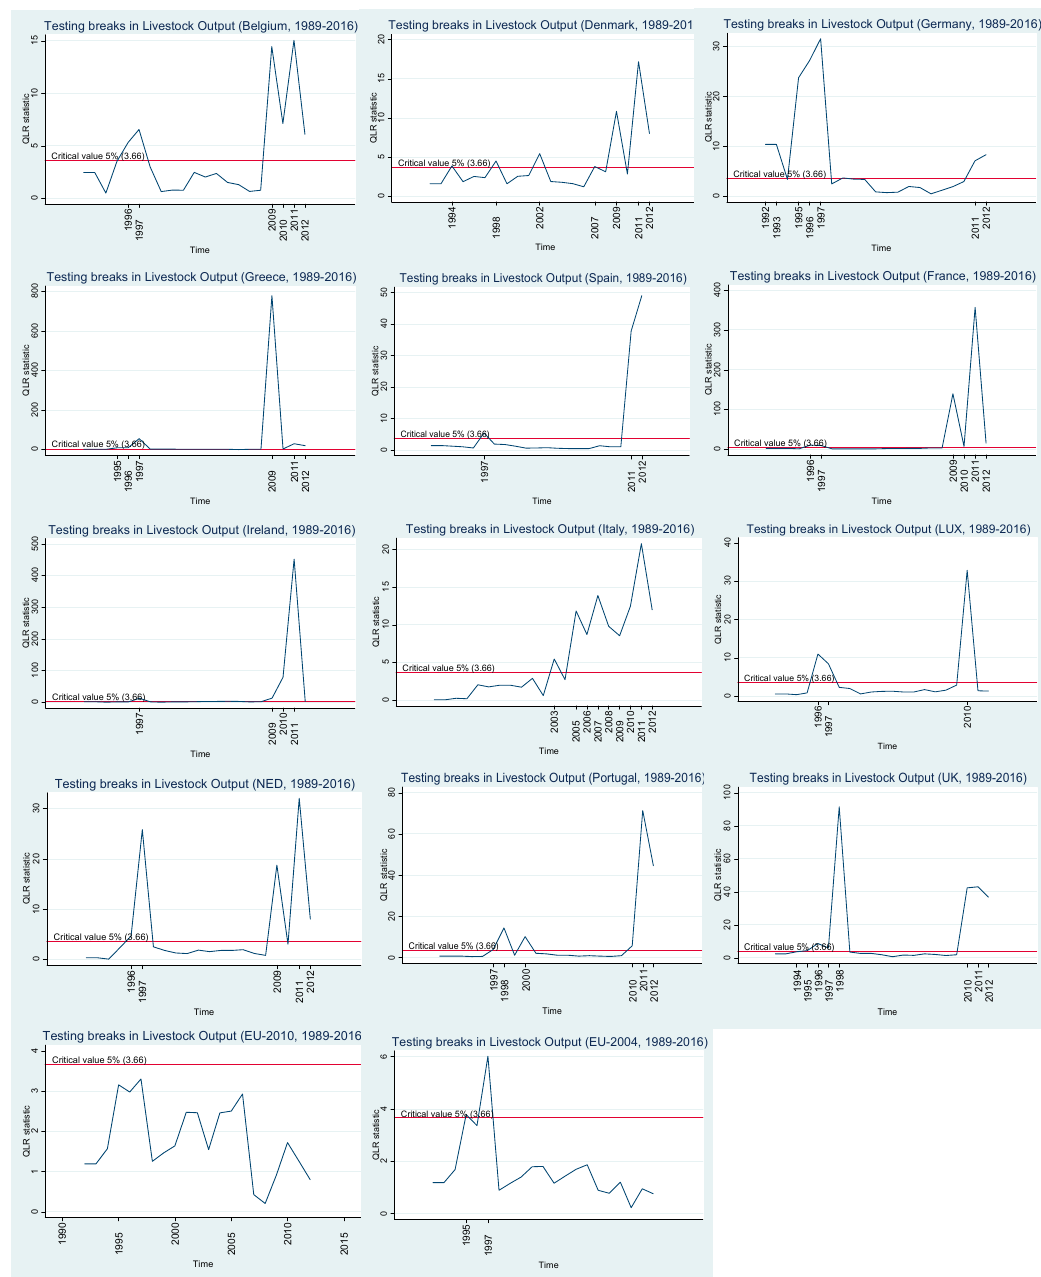
Figure 7. Testing for breaks in livestock output (euros) over the European Union countries